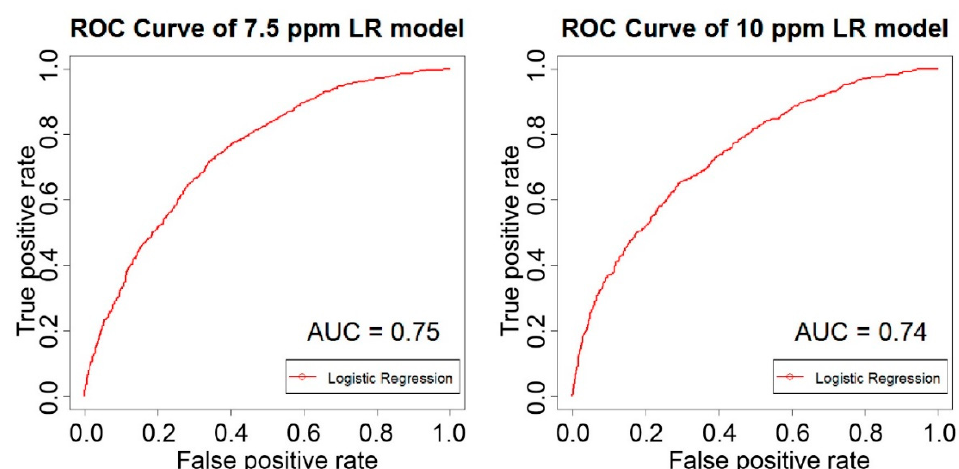
Figure 4. ROC curves indicating the ratio of true positives to false positives for the 7.5 mg NO 3 -N / L ( left ) and 10 mg NO 3 -N / L models ( right ). Deflection to the upper left indicates model predictive power. Table 3. Estimated number of wells exceeding 7.5 mg NO 3 -N / L and 10 mg NO 3 -N / L threshold under intensive cropping systems from 2009 to